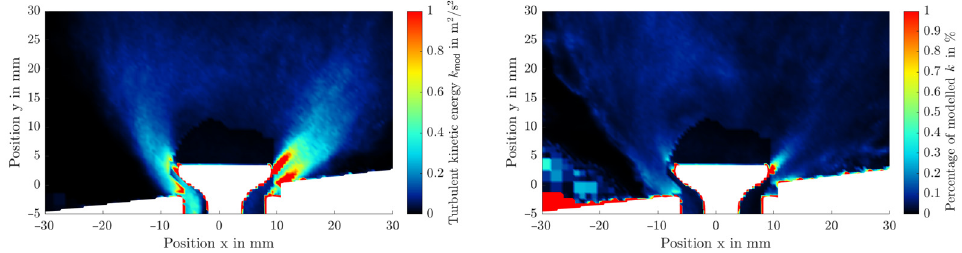
Figure 15. Modelled turbulent kinetic energy at 4 mm and 39.6 kg/h in LES ( left ) and percentage of modelled turbulent kinetic energy ( right ).